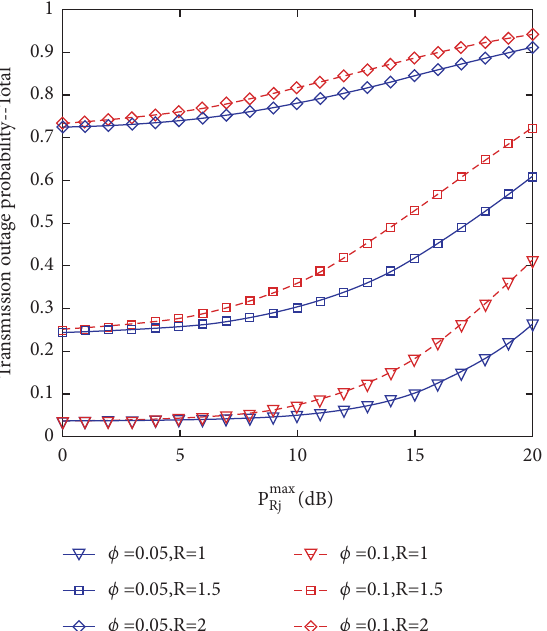
Figure 20: Total transmission outage probability versus P max σ 2 R � 0 dB , and σ 2 B � 0 dB